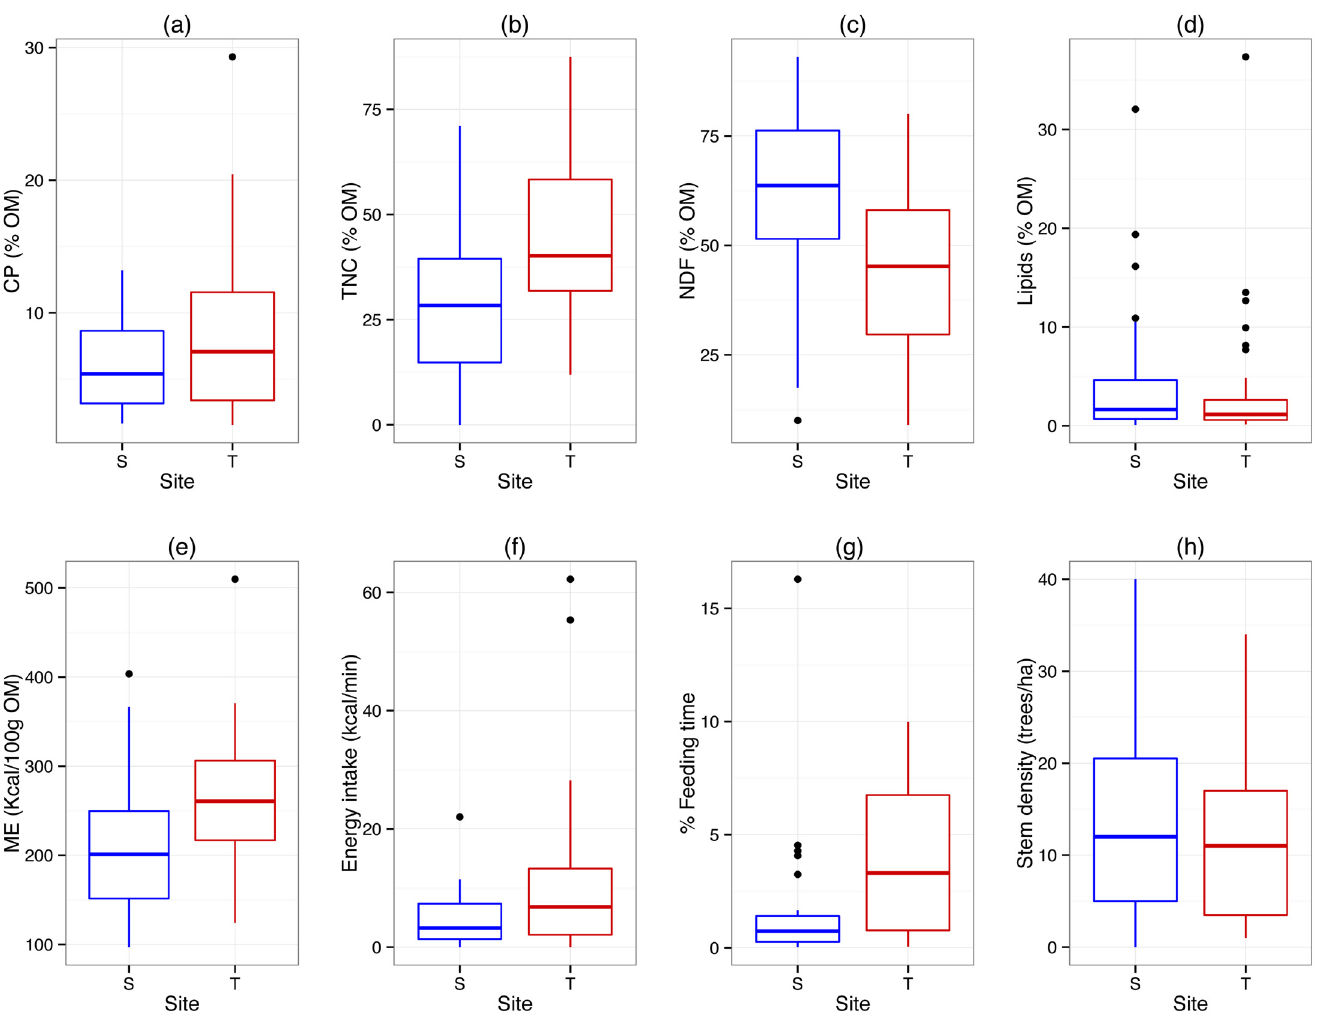
Fig 2. Matched plant species comparisons of dietary items in Tuanan (T) and Sabangau (S). All macronutrient and energy comparisons are based on organic matter (OM) and Matched Wilcoxon Rank Tests were used. A negative S-statistics indicates Tuanan is greater. (a) Crude protein (S = -207, p = 0.003); (b) TNC (S = -284, p < 0.0001); (c) NDF (S = 291, p < 0.0001); (d) Lipids (S = 109, p = 0.13); (e) Metabolizable energy (Kcal/100g OM)(S = -235, p = 0.0005; (f) Energy intake (Kcal/min) (S = 52.5, p = 0.049); (g) Percentage of time feeding on plant items (S = -106, p = 0.001). See Table 2 for complete statistical